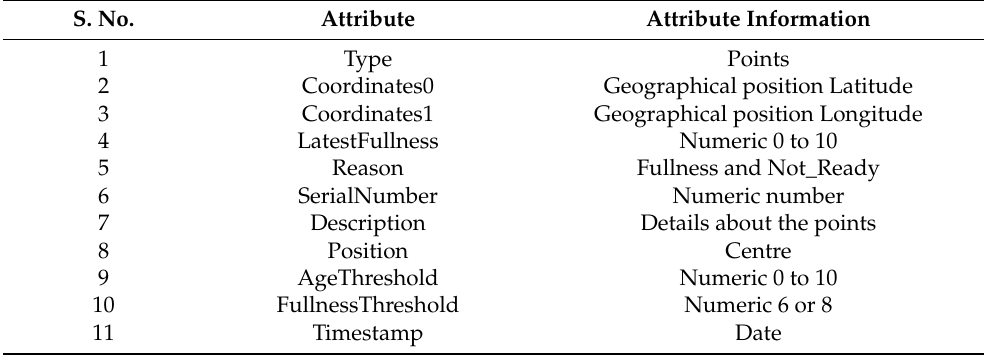
Table 2. Detail description of the collected data set. S.